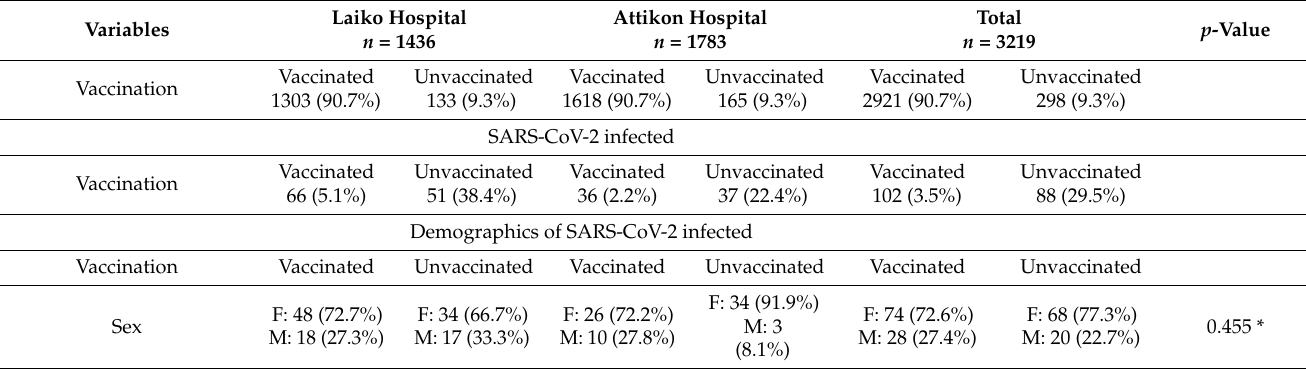
Table 2. Demographic and clinical characteristics of vaccinated and unvaccinated Health-Care- Workers (HCWs) with